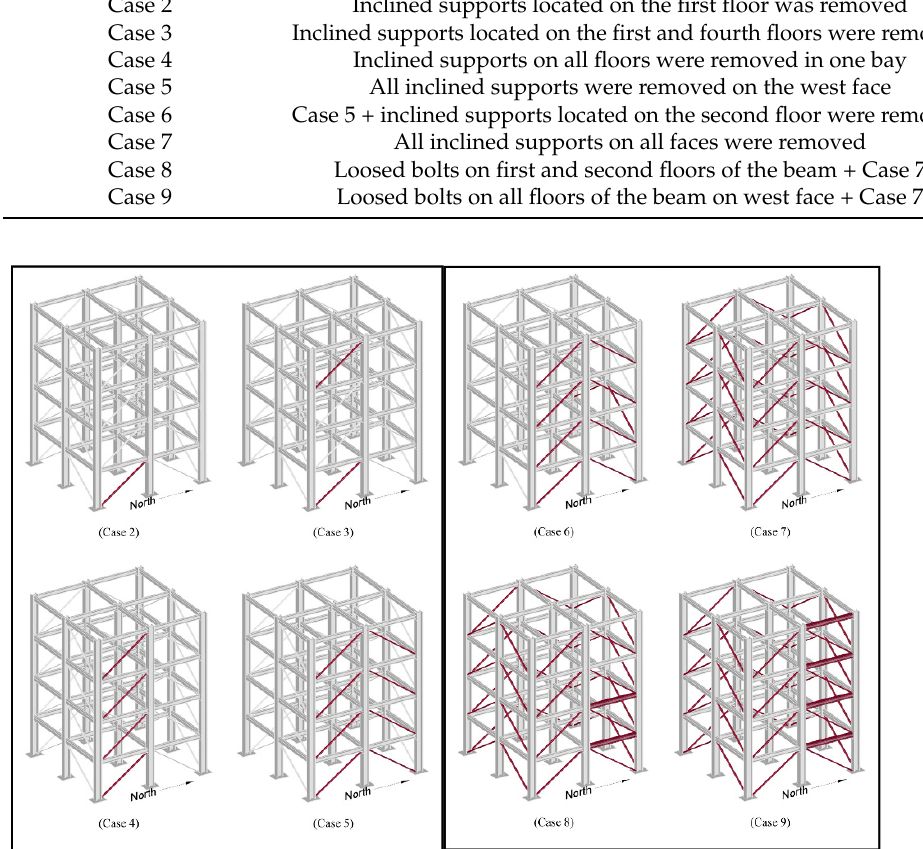
Figure 16. Structural damaged condition 2–9 of ASCE benchmark. (Red color denotes removed inclined supports locations or loosed bolts).